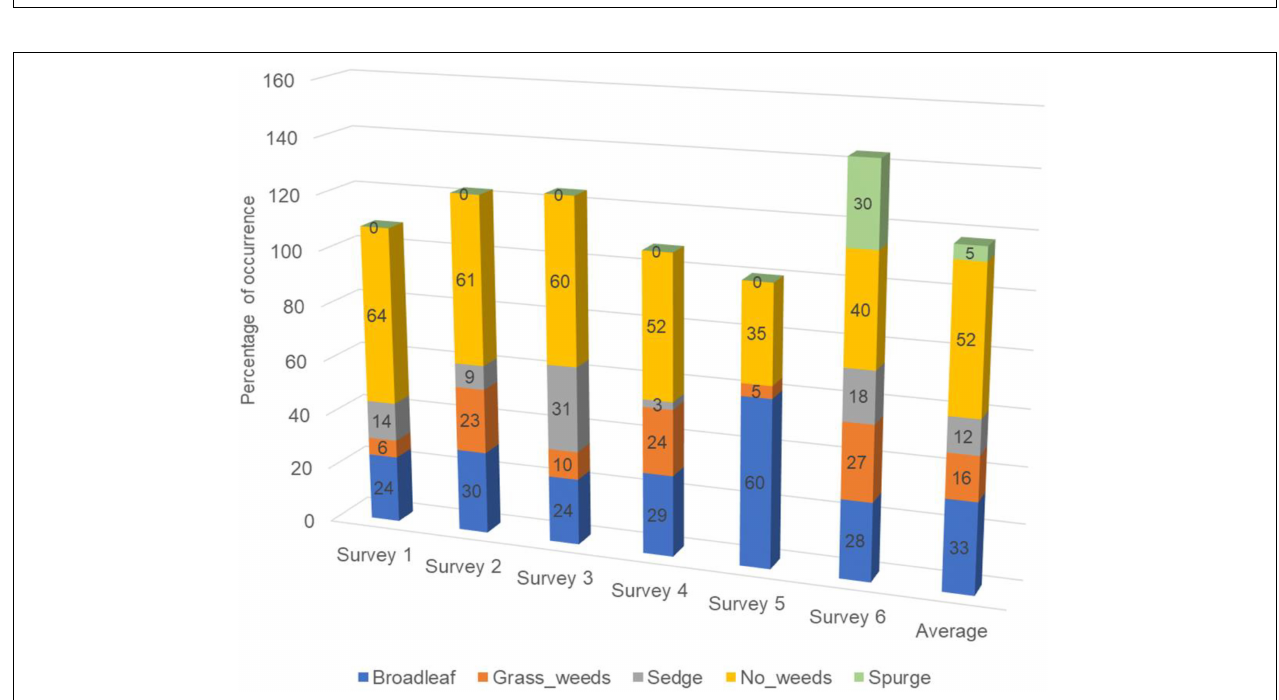
FIGURE 3 | Percentage of area (cells) with different weed types presented in six surveys corresponding to the surveys summarized in Table 1 . All surveys were conducted on Georgia sod farms in 2019 and 2020.